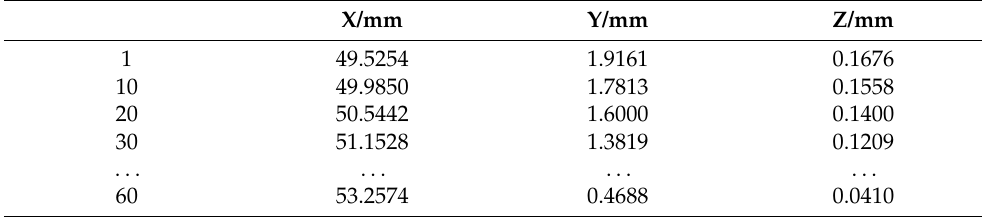
Table 5. Partial data of coordinates of the side cutting